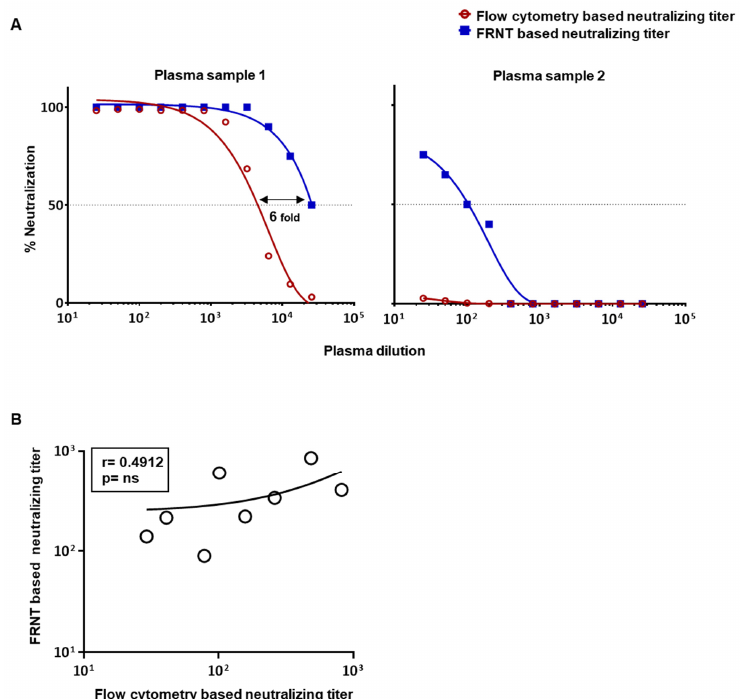
Figure 2. Comparison of neutralization titers obtained by FRNT and flow cytometry based assays in human plasma samples using the standard protocol. ( A ) The horizontal dotted line plotted over the nonlinear dose–response regression analysis indicates the dilution of plasma needed to cause 50% reduction in neutralization of DENV2 using FRNT (blue line) and flow cytometry based assays (red line). Neutralizing assay of plasma samples with very high (plasma sample 1) and very low (plasma sample 2) neutralization titers are shown. ( B ) Correlation analysis of the calculated 50% neutralization titer in an additional 8 individual plasma samples’ intermediate titers using the FRNT- and flow cytometry based assays. Sample 1 and sample 2 shown in panel A are not included in the correlation analysis in panel B due to the outlier nature of these samples and inability to calculate neutralization titer for sample 2 by flow cytometry based assay [23].